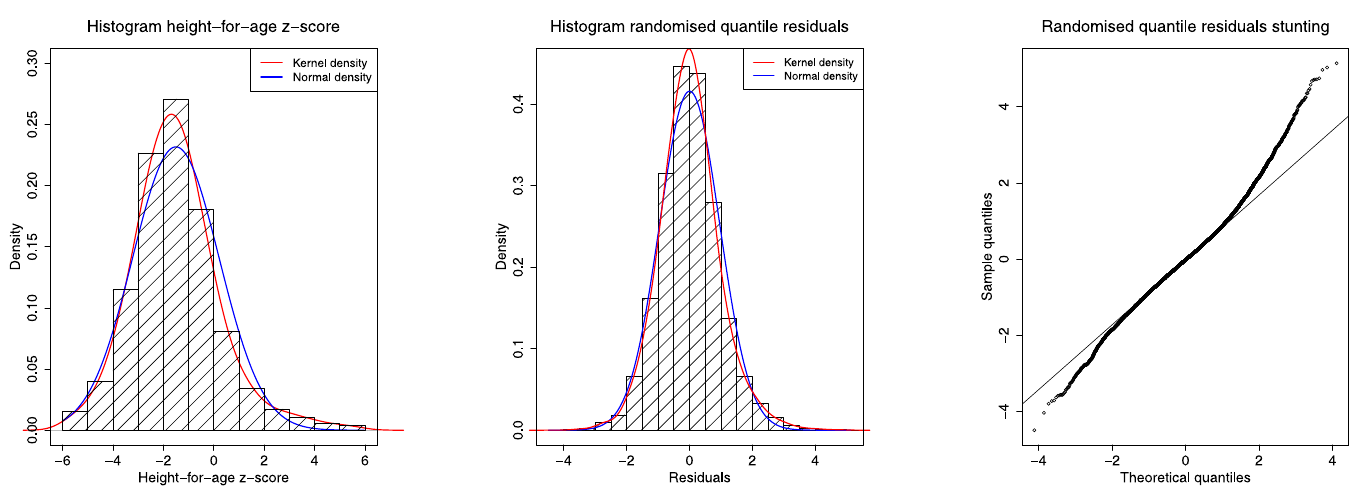
Fig 2. Histogram of the response and histogram and QQ-plot of the randomised quantile residuals. The left-hand panel shows the histogram and kernel density estimates of the height-for-age z-score, the middle panel shows the histogram of the randomised quantile residuals together with the normal density estimates, and the right-hand panels depicts the QQ-plot of the randomised quantile residuals. Source : Demographic and Health Surveys (data); calculation by authors.